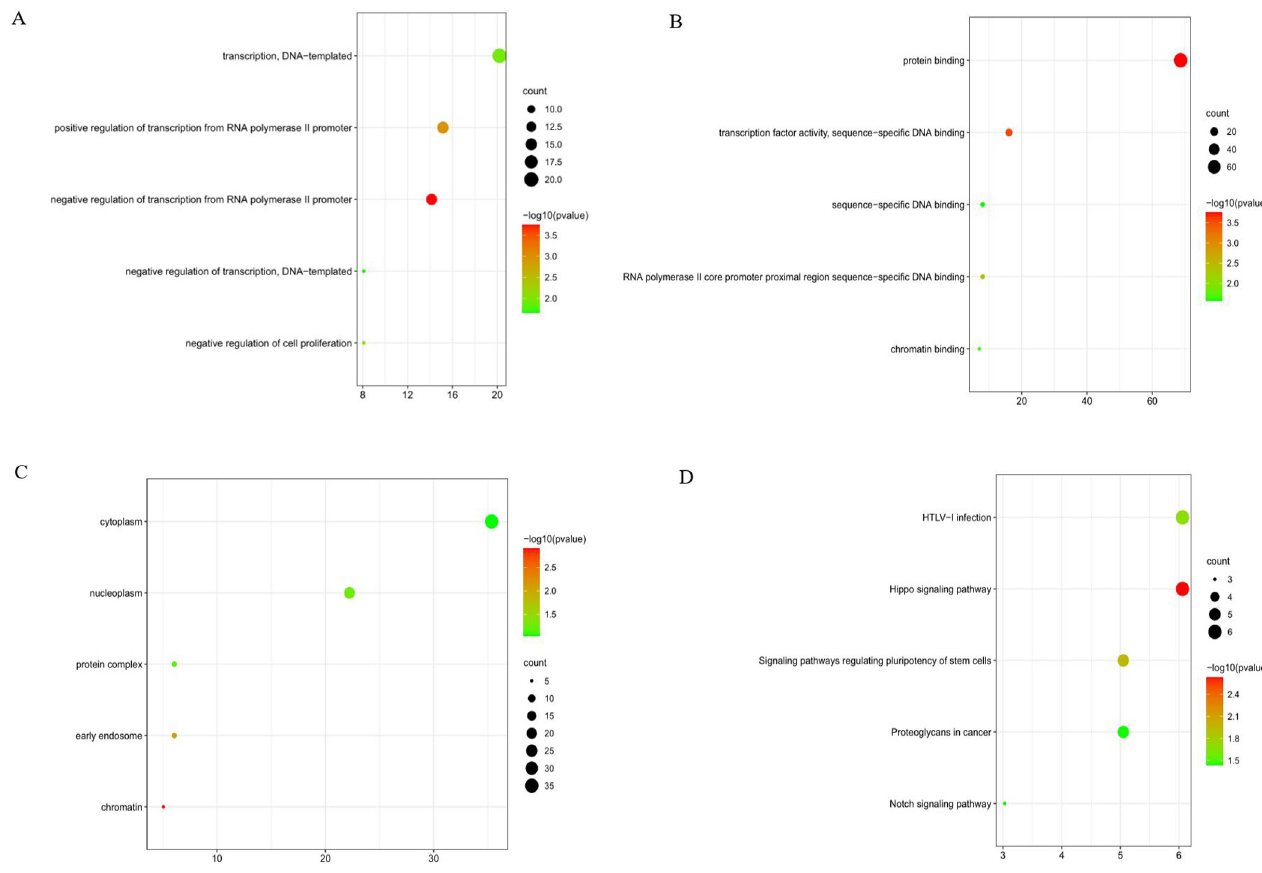
Fig 8. GO and KEGG analyses of target